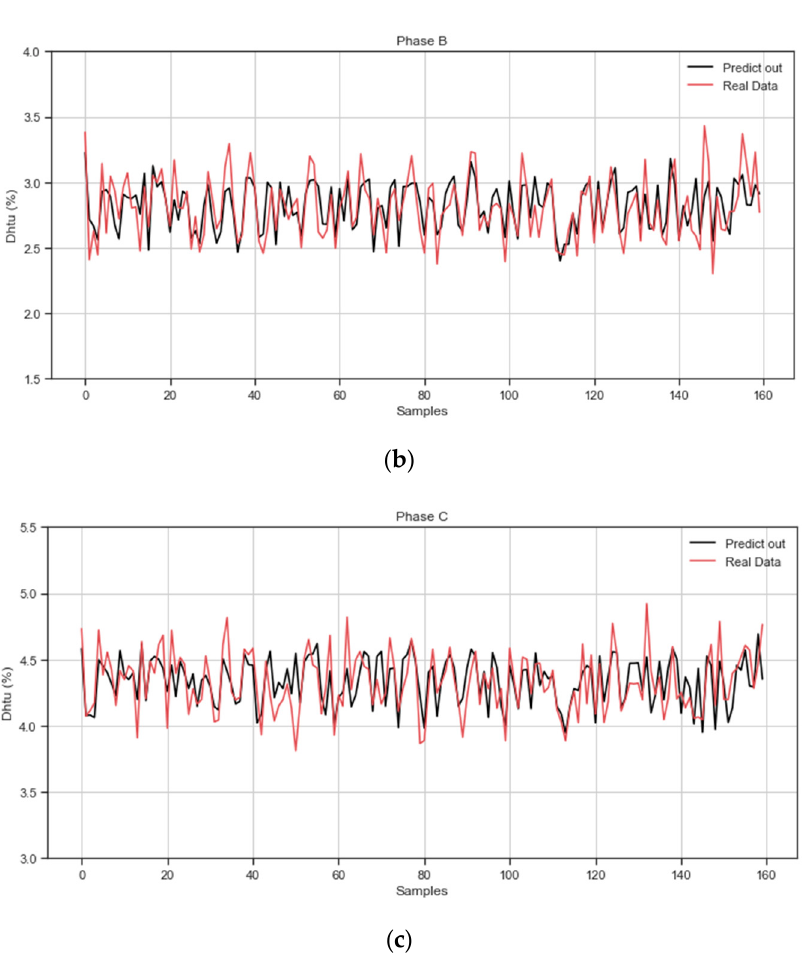
Figure 7. THDu measured at the coupling point, Main Power Cabin, during the experiment period in ( a ) phase A ( b ) phase B ( c ) phase C from test set data.